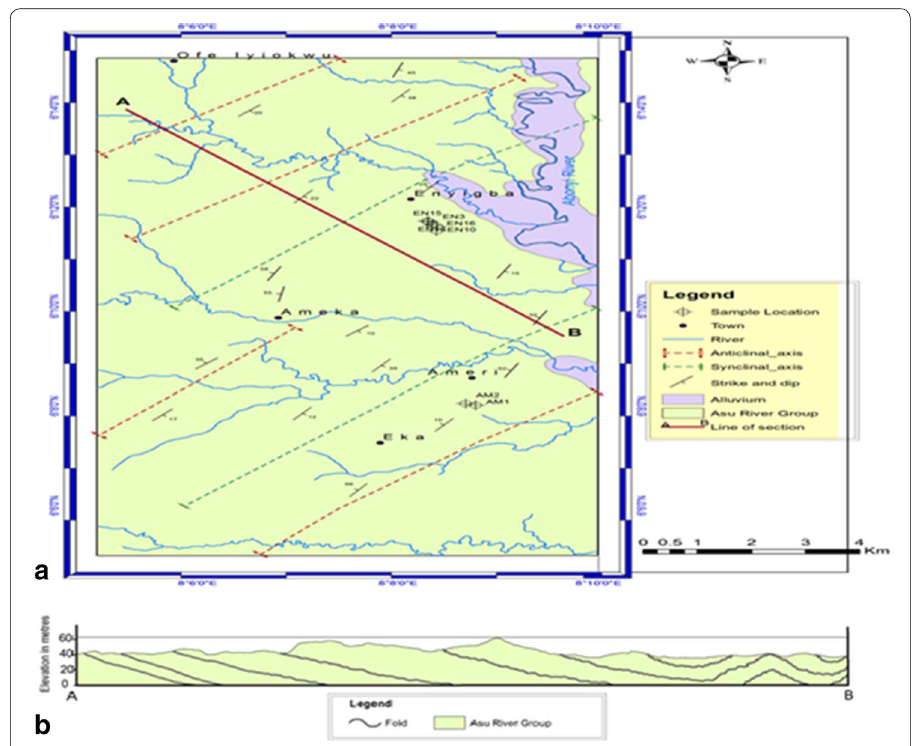
Fig. 4 Geologic map of the study area. a Geologic features, b cross